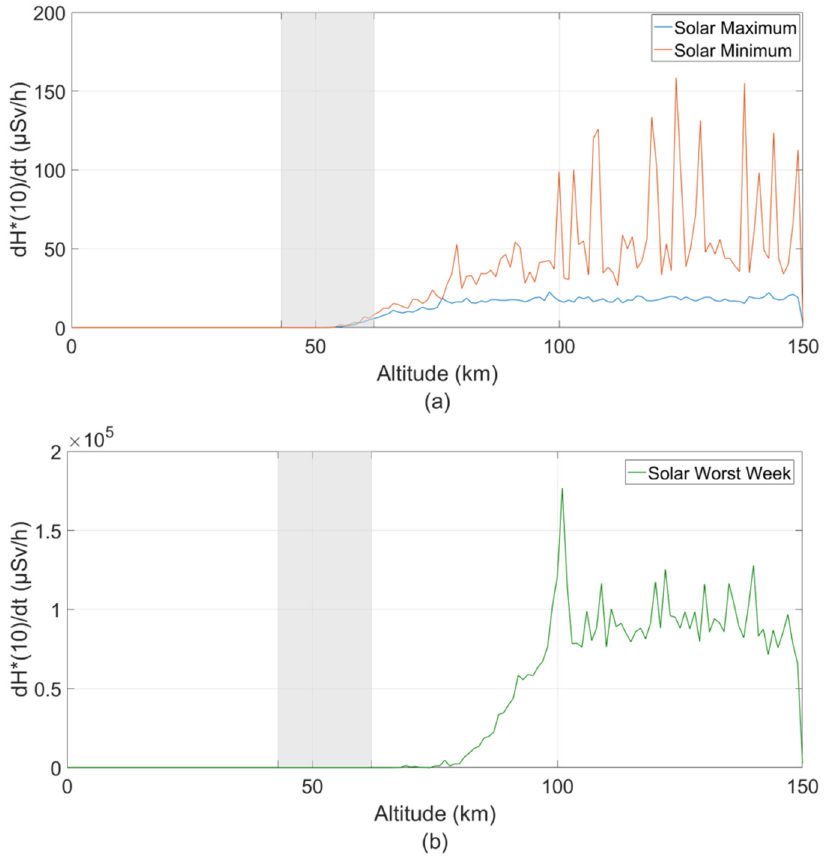
Figure 4. The ambient dose equivalent rate for different altitudes in the atmosphere of Venus during solar minimum and solar maximum conditions ( a ) and the Worst Week scenario ( b ).